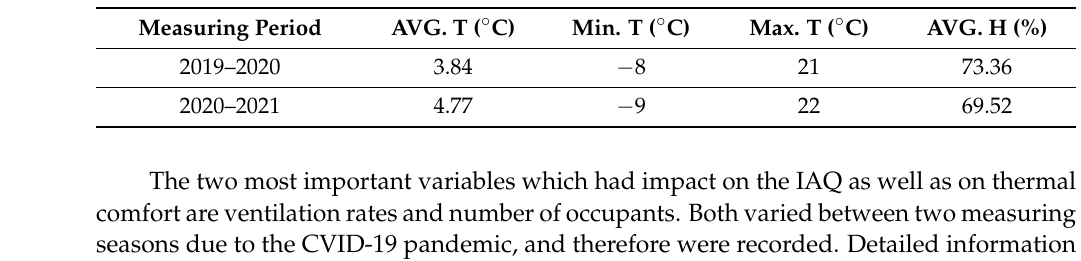
Table 5. Outdoor air parameters: air temperature T ai , relative humidity RH ai (MIN—minimum measured value, MAX—maximum measured value, AVG—average measured value during the children’s presence in the